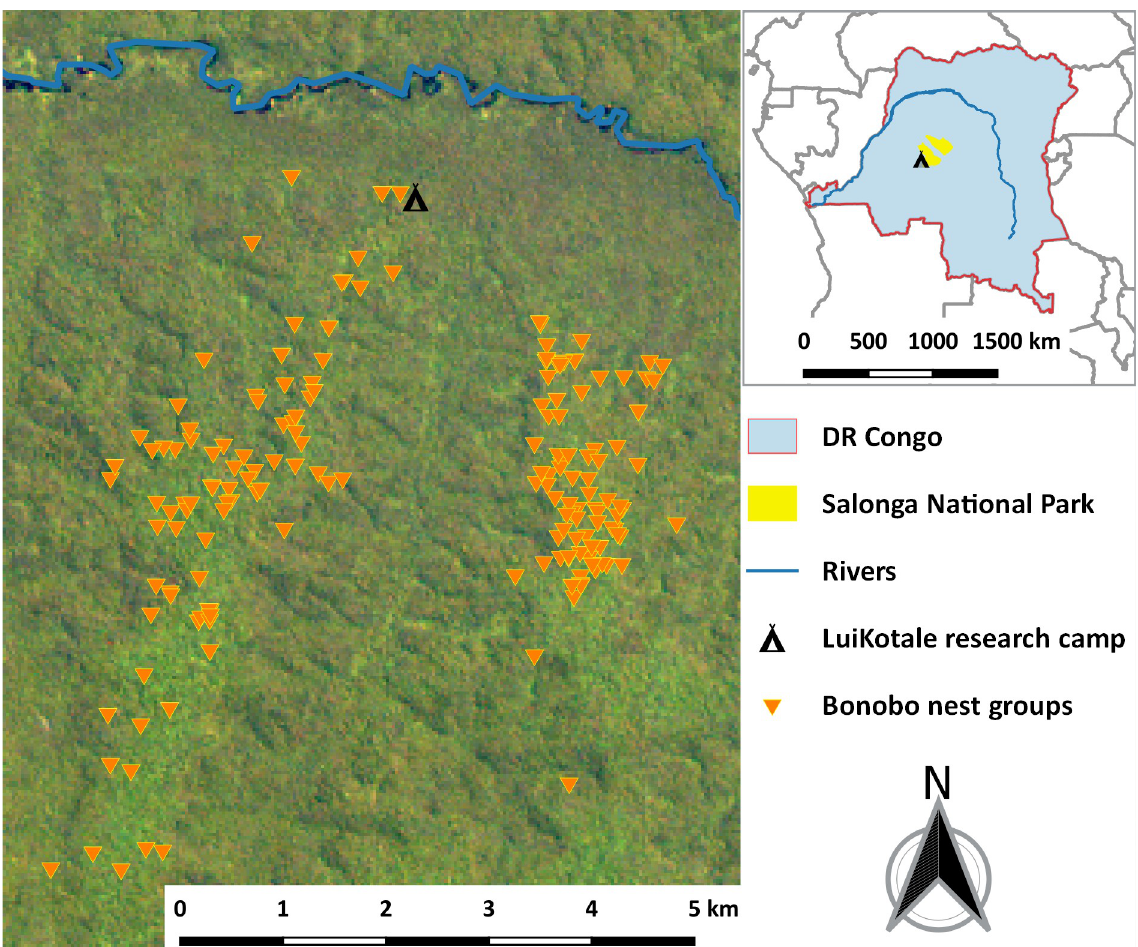
Fig 1. Nest groups (n = 182; orange triangles) monitored in the LuiKotale Study area (2003–2018) situated west of Salonga National Park (yellow) in the Democratic Republic of the Congo (light blue). Landsat-8 image courtesy of the U.S. Geological Survey.